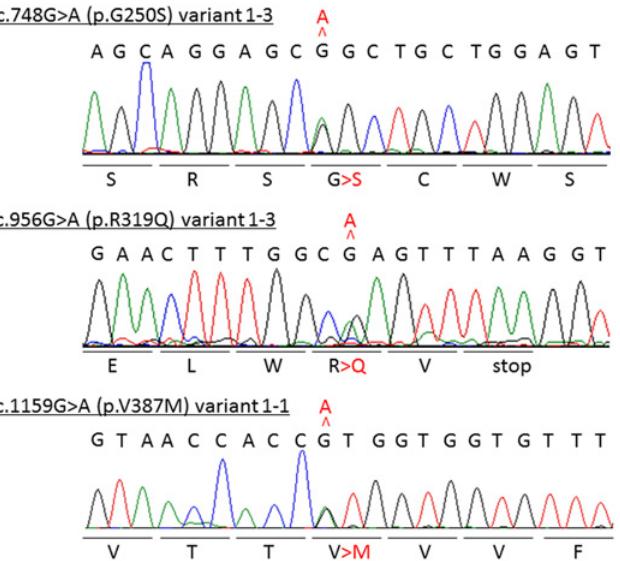
Fig 3. Electropherograms of the identified CLCN6 variants confirmed by Sanger sequencing. Identified variants are shown in